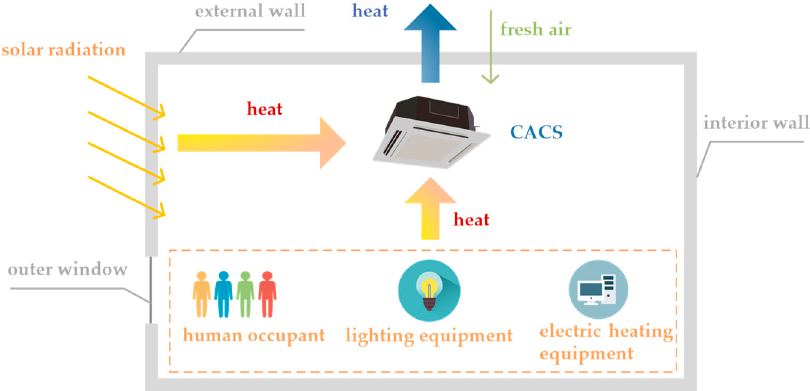
Figure 2. Diagram of public building energy conservation.